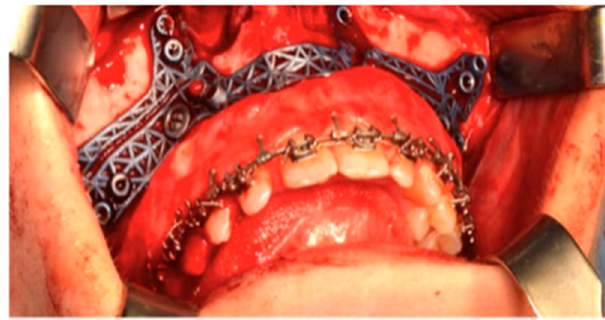
Figure 7. The cutting guides in position.